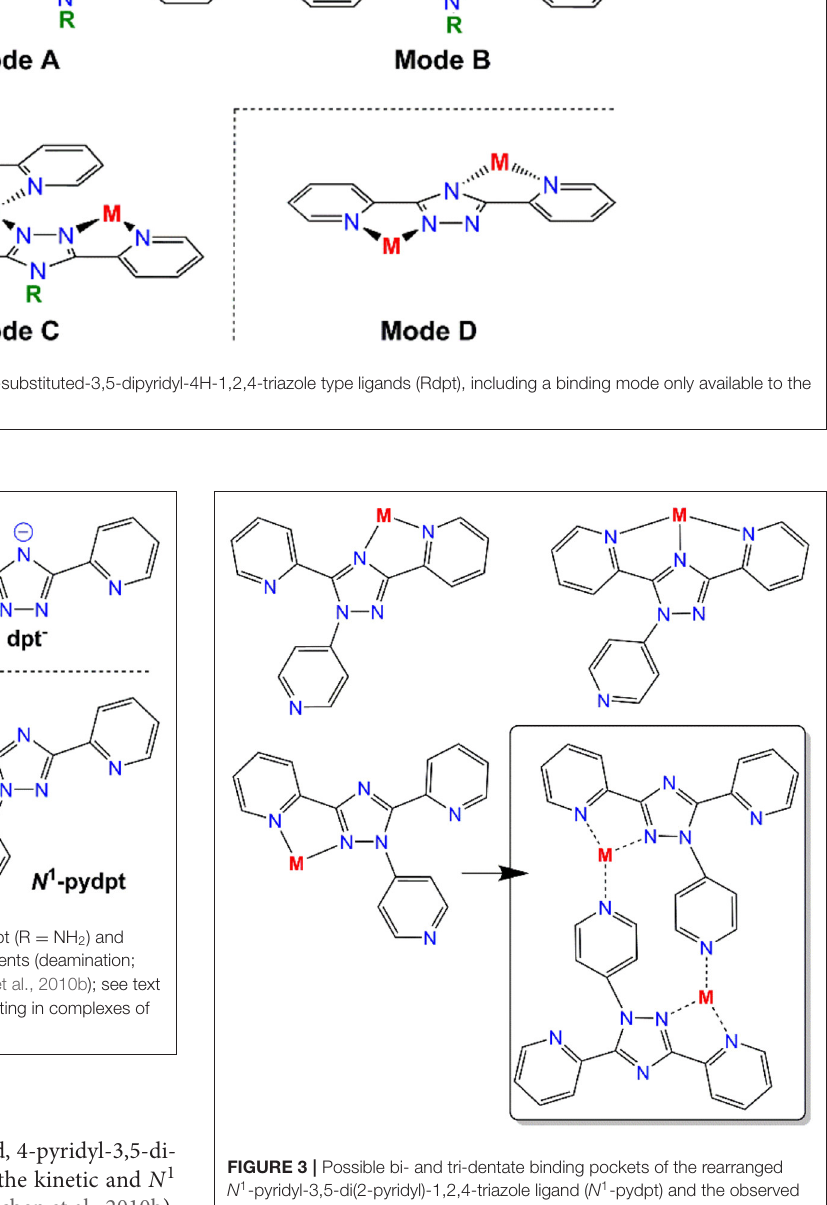
FIGURE 3 | Possible bi- and tri-dentate binding pockets of the rearranged N 1 -pyridyl-3,5-di(2-pyridyl)-1,2,4-triazole ligand ( N 1 -pydpt) and the observed binding mode in dinuclear complex 4 (box) which also features bridging by the 4-pyridyl substituents at N 1 of the triazole rings. crystals of the dinuclear complex of the rearranged